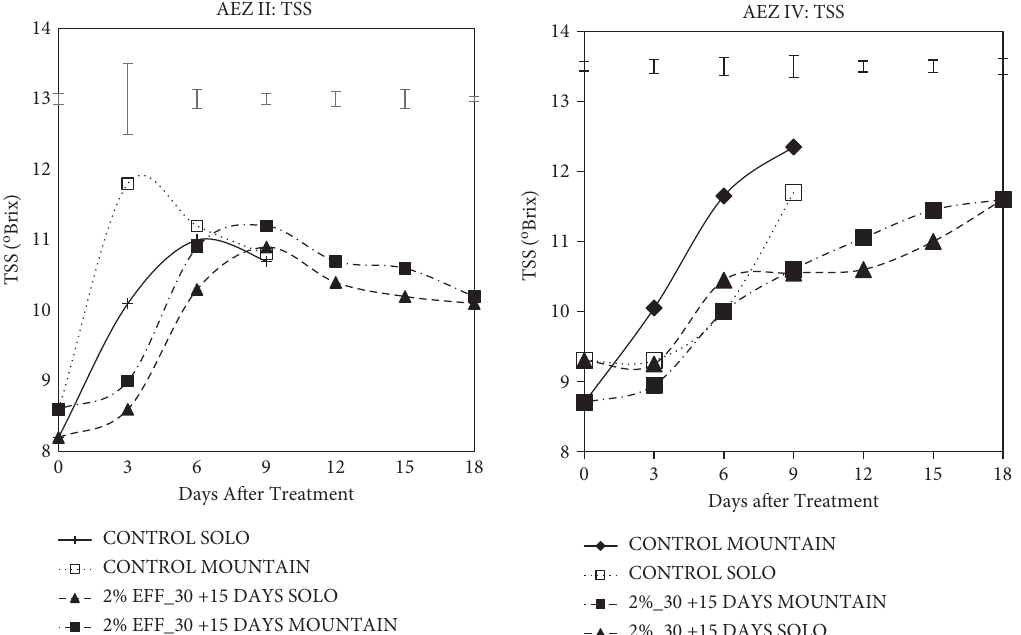
Figure 7: Percent TSS present in papaya fruits treated with Hexanal spray from Machakos and Meru counties. Top bars represent LSD at 0.05.